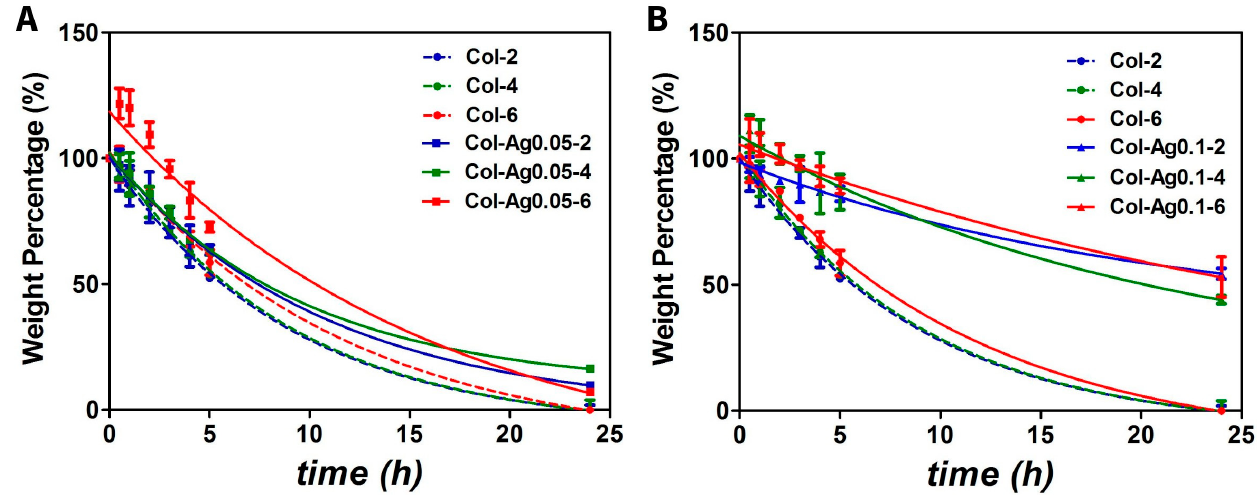
Figure 7. Collagenase degradation test of 3D-printed collagen-based scaffolds. Weight percentage is shown as a function of time comparing Col with Col-Ag0.05 ( A ), and Col with Col-0.1 ( B ). Col-2(– • –blue), Col-4(– • –green), Col-6 (– • –red), Col-Ag0.05-2 (- (cid:4) -blue), Col-Ag0.05-4 (- (cid:4) -green), Col-Ag0.05-6 (- (cid:4) -red), Col-Ag0.05-2 (- (cid:78) -blue), Col-Ag0.05-4 (- (cid:78) -green), and Col-Ag0.05-6 (- (cid:78) -red). Results are expressed as mean ± SD from triplicate